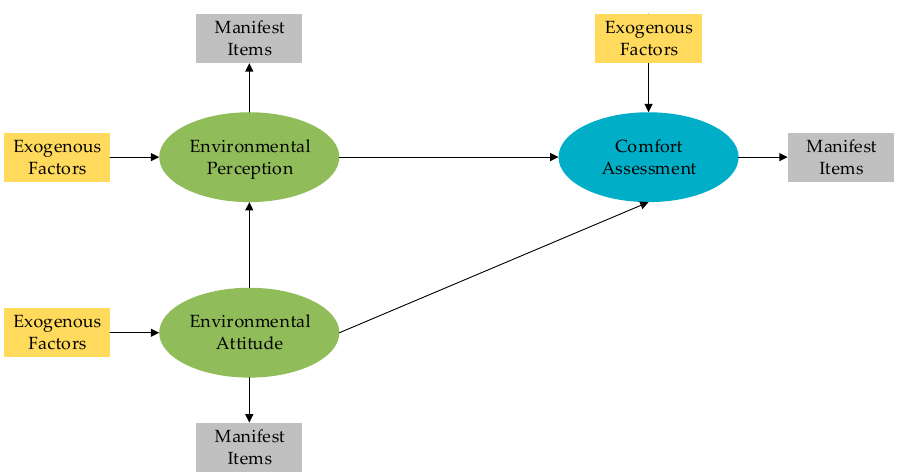
Figure 1. The diagram of conceptual framework .